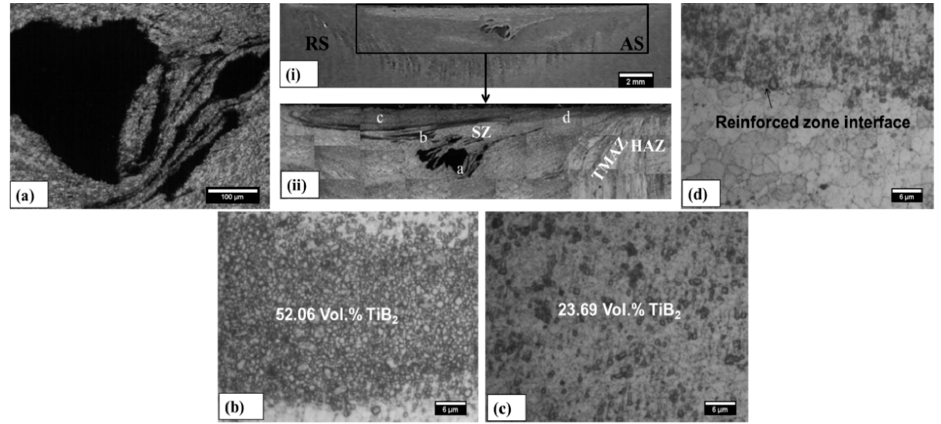
Figure 8. ( i ) Macro-image of cross-section of Sample 2. ( ii ) Microstructure of cross-section of the rectangle in macro-image showing: ( a ) agglomerated region; ( b ) mixed region; ( c ) dispersed region; and ( d ) AS interface. Metals 2018 , 8 , x FOR PEER REVIEW 11 of 15